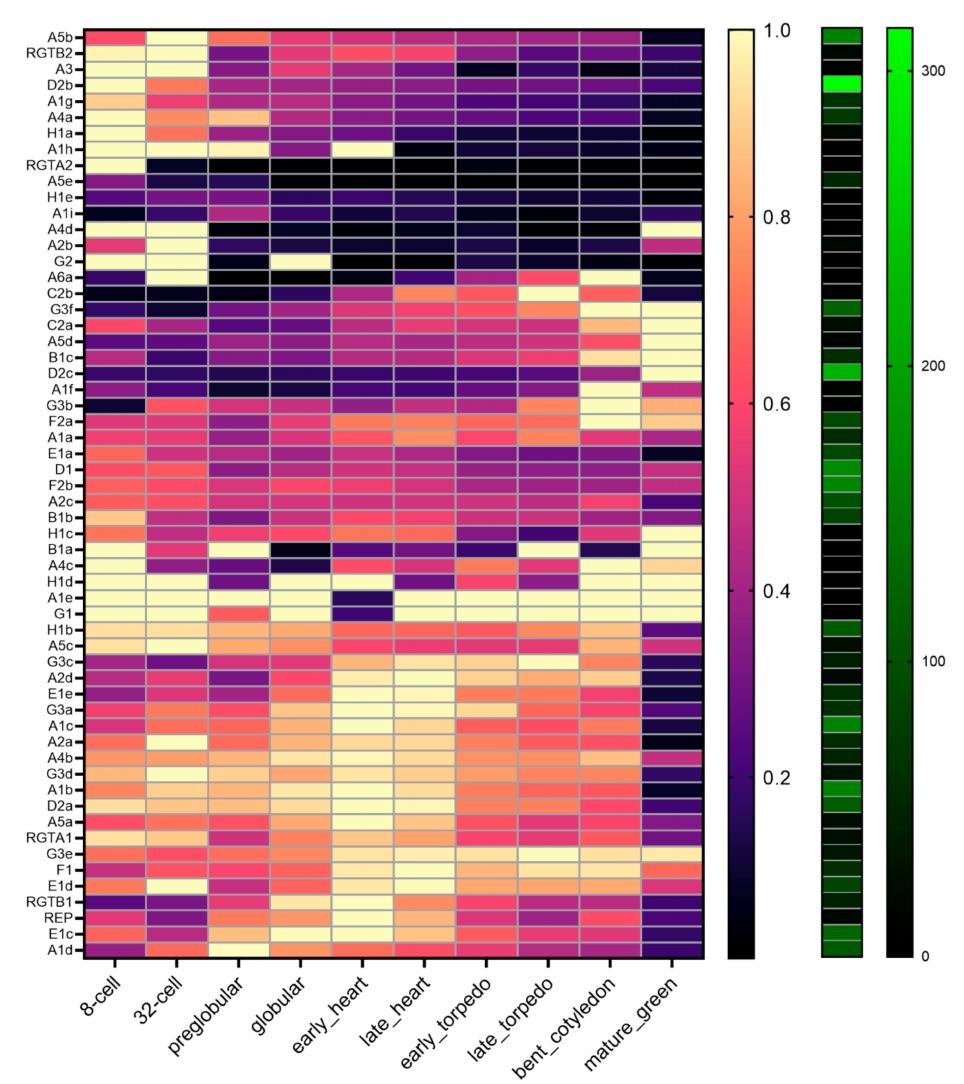
Figure 10. Transcriptomic analysis of RGT and Rab components during embryo development. In silico expression profiles during embryogenesis of the Rab and RGT complex genes were examined using publicly available transcriptome data [63]. RNAseq data were downloaded from the NCBI Gene Expression Omnibus (GEO; https://www.ncbi.nlm.nih.gov/geo/, accessed on 29 June 2021) under accession number GSE121236. Average expression values for each gene at each stage were calculated and then presented as a proportion of the maximum expression value for each gene, providing a relative expression value between 0 and 1. Expression profiles were clustered using hierarchical clustering (Pearson correlation) and heat maps were generated in GraphPad Prism 9.0.0. The maximum RPKM expression value for each gene in any given stage is indicated in the black-to-green heatmap on the